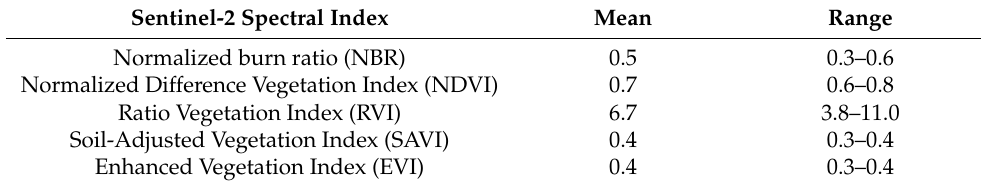
Table 5. Mean and range of Sentinel-2 spectral indices used in the study.